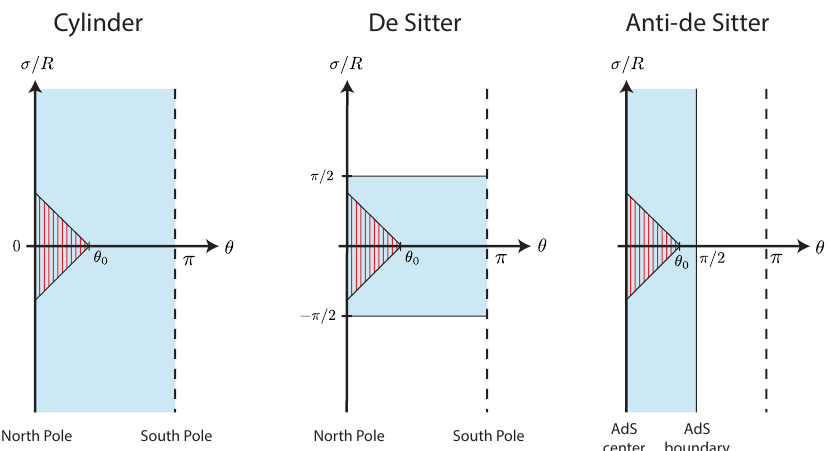
Figure 1 . Boundary space-times represented in the ( (cid:27)=R; (cid:18) ) plane. The blue region corresponds to the section of the ( (cid:27)=R; (cid:18) ) plane covered by the boundary metrics (2.31) (in the limit ! 0 and without the conformal factor), (2.34) and (2.36). In red we see the region in which the boundary vector (cid:24) a is time-like and therefore the extended (cid:12)rst law of entanglement applies. is de(cid:12)ned in the Lorentzian cylinder R (cid:2) S d (cid:0) 1 with metric ds 2 bulk coordinate ^ (cid:18) becomes the polar angle ^ (cid:18) = (cid:18) on the spatial sphere S d (cid:0) 1 , with (cid:18) = 0 ; (cid:25) corresponding to the North and South poles